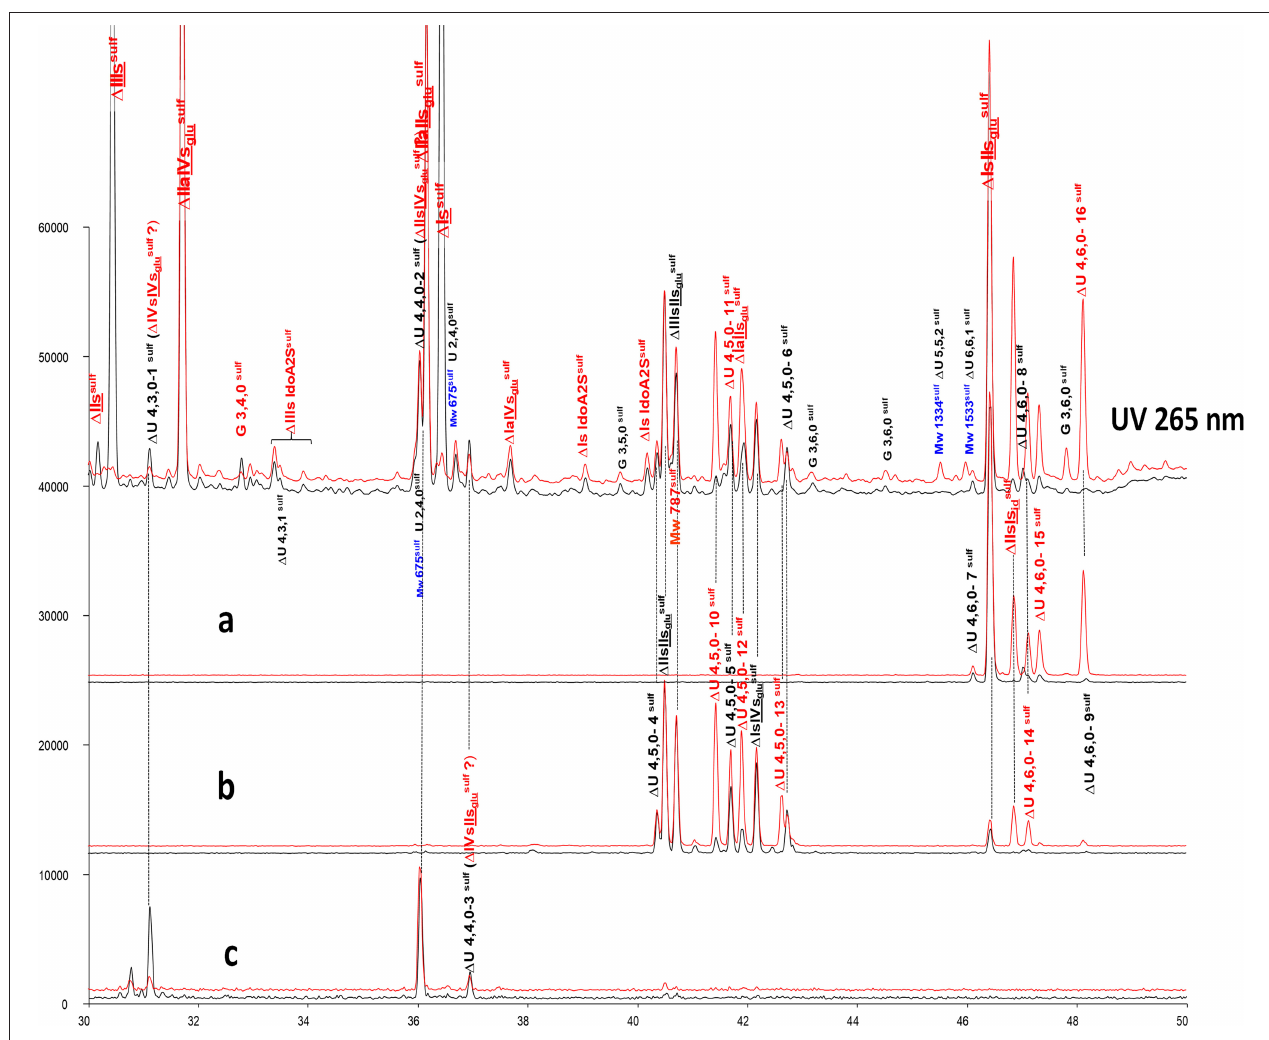
FIGURE 6 | Comparison by ion-pair liquid chromatography/mass spectrometry of heparinase I + II + III ( — ) and heparinase II ( — ) digests of bovine mucosal heparin (BMH) high-affinity (HA3) fraction after sulfanilic reductive amination. (a) Reconstructed ion pair chromatograms (RIC) 1 U(4,6,0) sulf : m/z 712.2; (b) RIC 1 U(4,5,0) sulf : m/z 614.5 + 672.1; (c) RIC 1 U(4,4,0) sulf + 1 U(4,3,0) sulf : m/z 534.5.